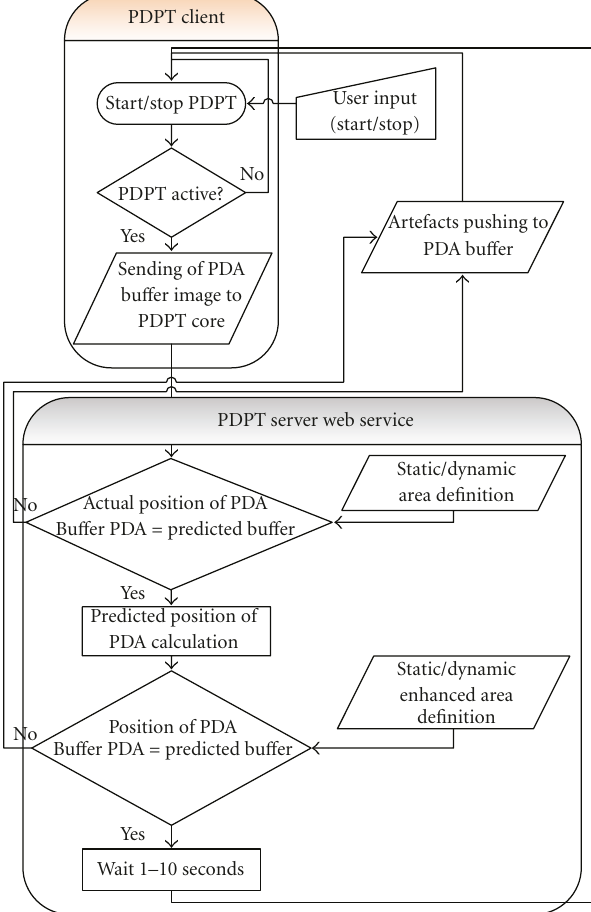
Figure 4: PDPT Framework—UML Design of flow diagram. The artefacts collections which belong to the actual user position are copied to PDA bu ff er firstly. The predicted position and new artefacts collection is used if all artefacts are already loaded to PDA bu ff er. The definition of the Static or Dynamic area depends on the specific case of artefacts size, area size of where the PDPT framework is